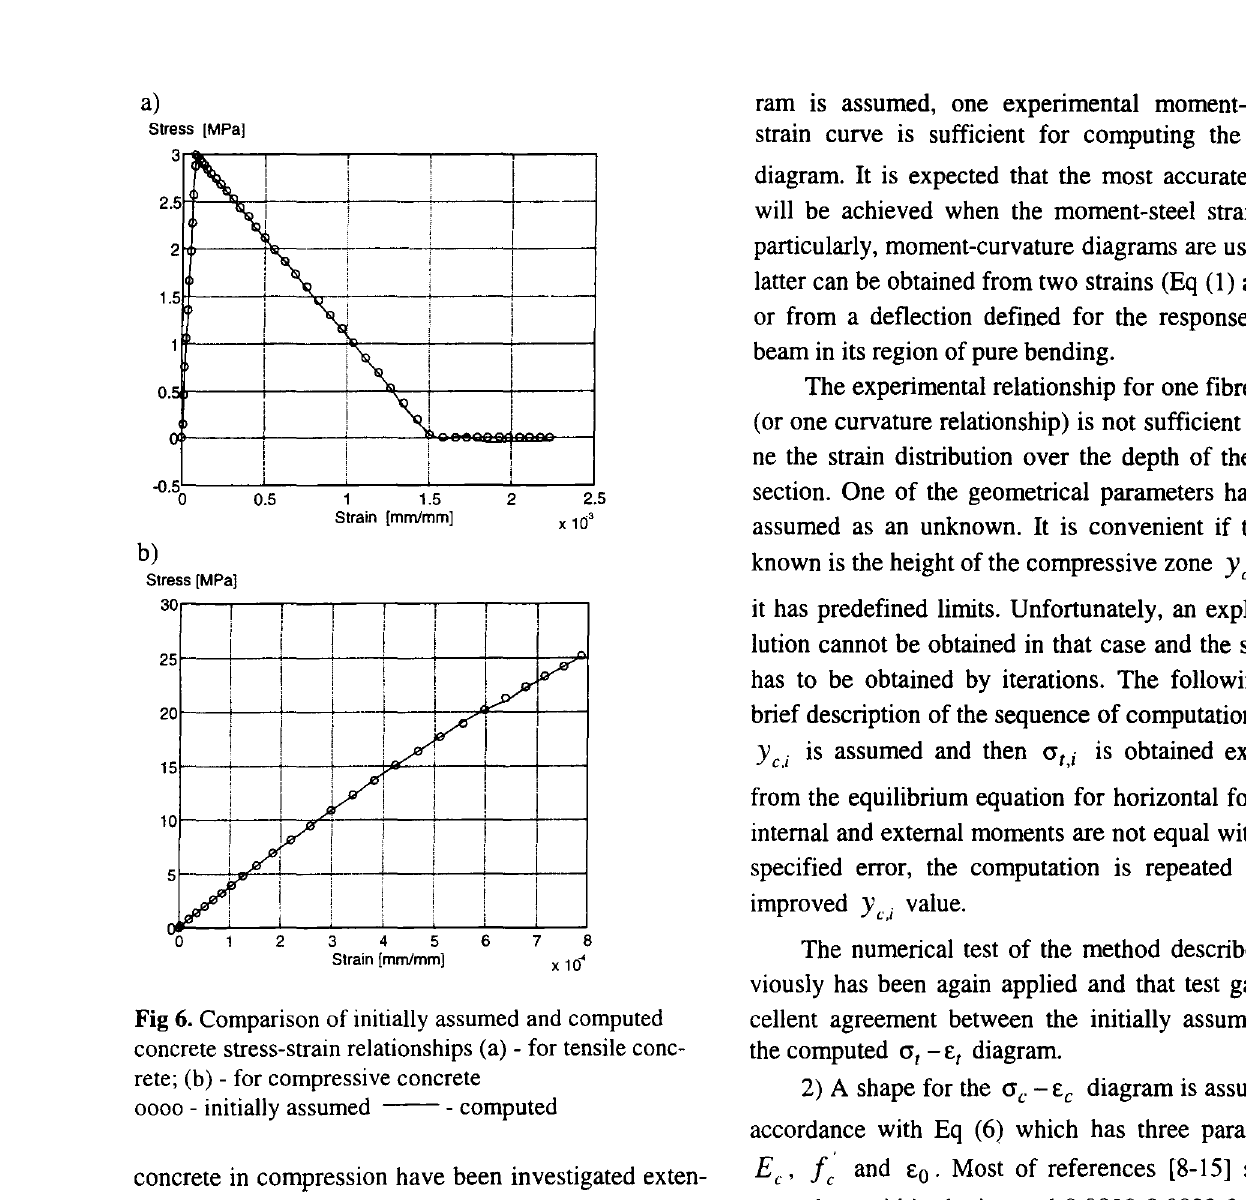
Fig 6. Comparison of initially assumed and computed concrete stress-strain relationships (a)- for tensile conc rete; (b)- for compressive